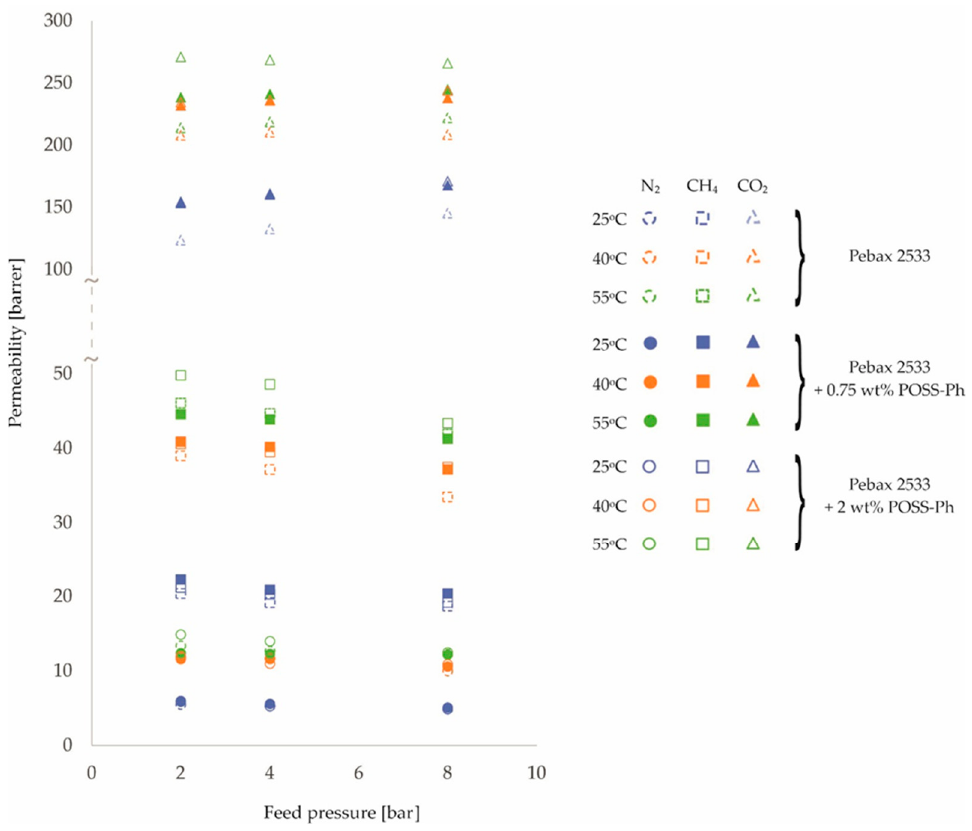
Figure 3. Change in permeability values of homogeneous membrane and heterogeneous membranes containing POSS ‐ Ph for different feed pressure and temperature values.